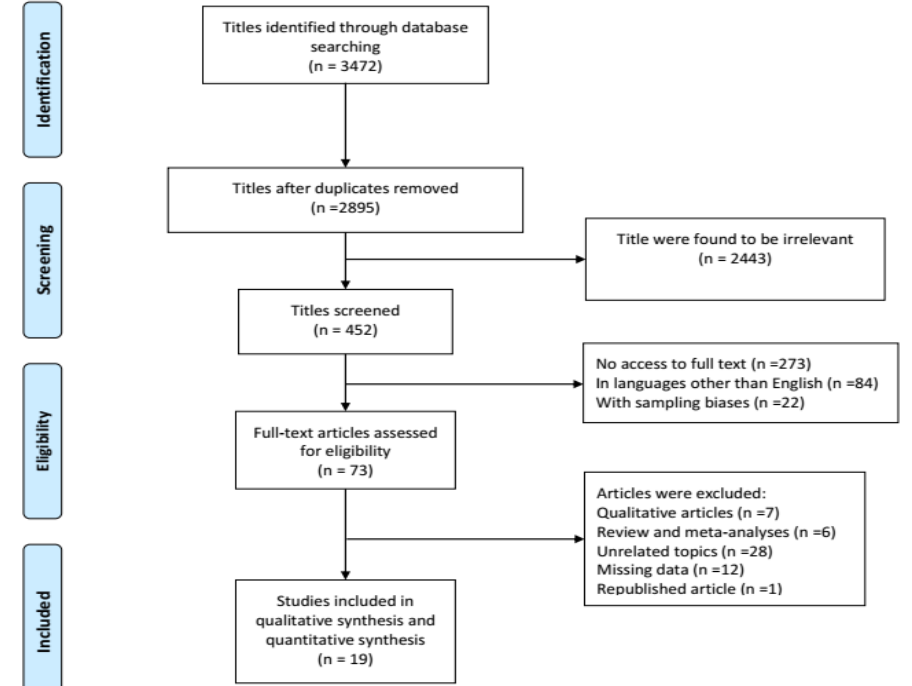
Figure 1. Screening process for the retrieved articles based PRISMA (Preferred Reporting Items for Systematic Reviews And Meta-